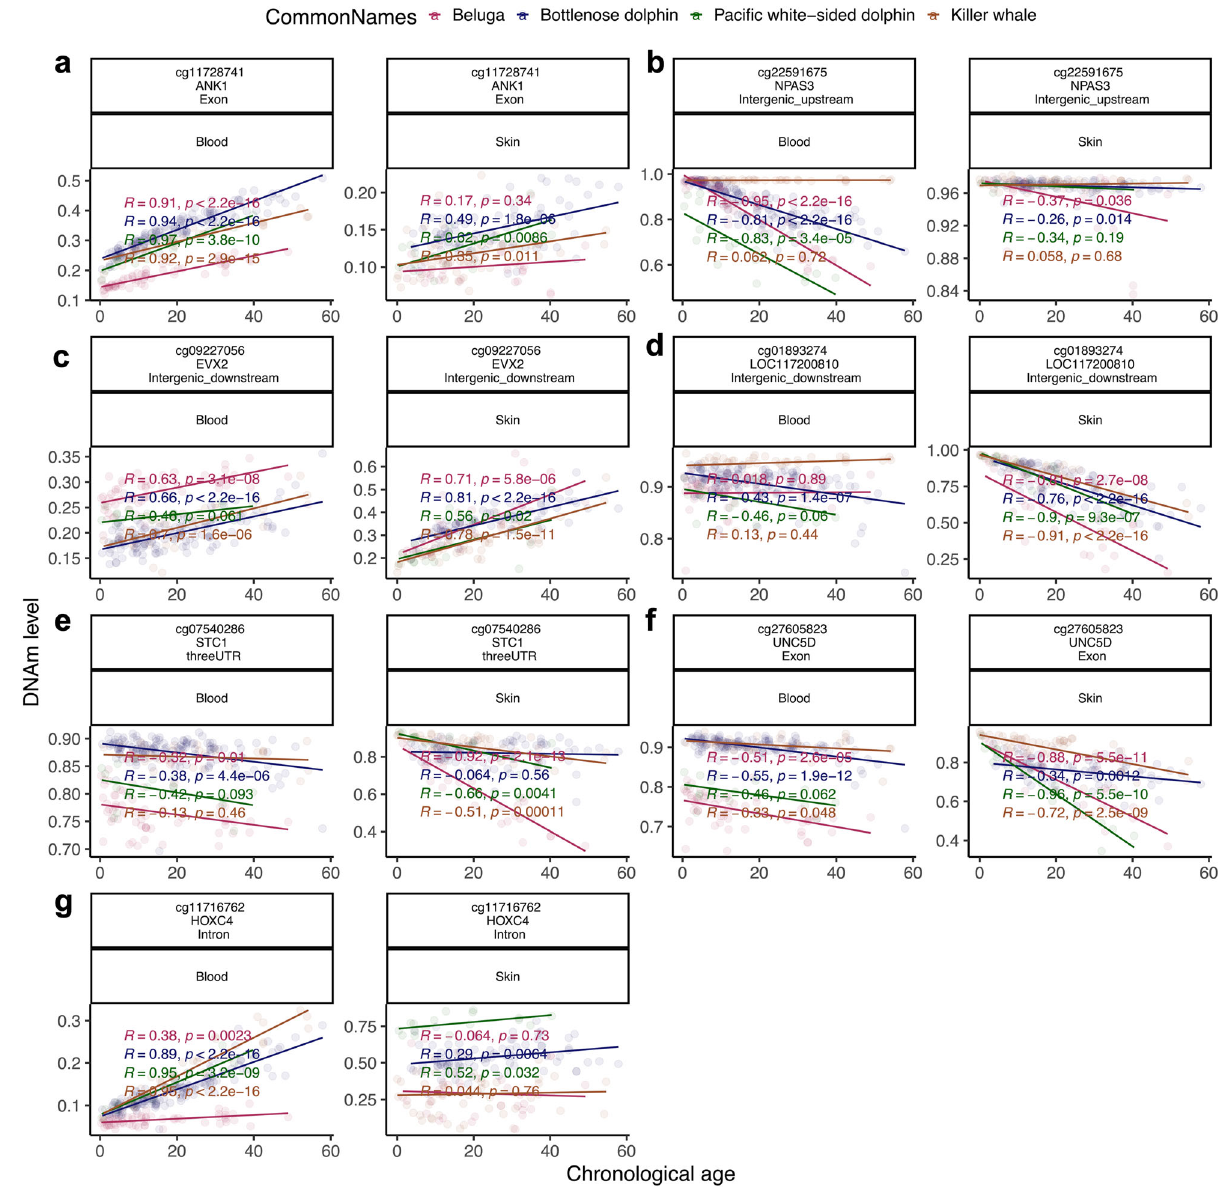
Fig. 4 DNAm aging in top CpGs from EWAS of chronological age in blood and skin of odontocetes. Top CpGs proximate to genes: a ANK1 exon, which was the top region in the blood of bottlenose ( z = 20.6) and Paci fi c white-sided ( z = 7.8) dolphins; b NPAS3 upstream from beluga blood ( z = − 14) EWAS; c EVX2 downstream from bottlenose dolphin skin ( z = 10.3); d LOC117200810 downstream from killer whale skin ( z = − 10.9) EWAS; e STC1 3 ′ UTR from beluga skin EWAS ( z = − 8.5); f UNC5D exon from Paci fi c white-sided dolphin skin ( z = − 7.7); g HOXC4 intron from killer whale blood ( z = 10.7).